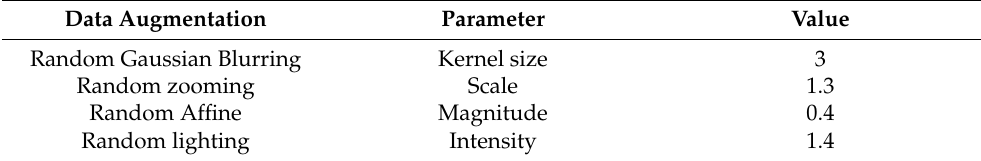
Table 2. Data Augmentation